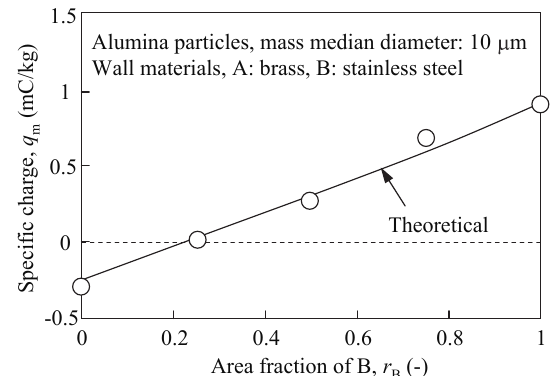
Fig. 6 Effect of area fraction of wall materials on parti- cle charging (spherical alumina particles, mass median diameter: 10 μ